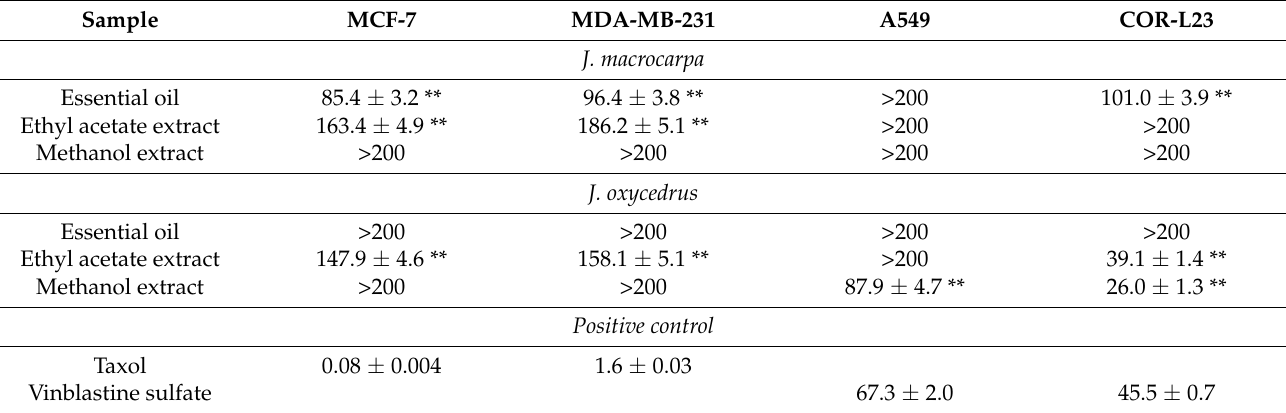
Table 4. Anti-proliferative activity (IC 50 µ g/mL) of essential oils and extracts of J. macrocarpa